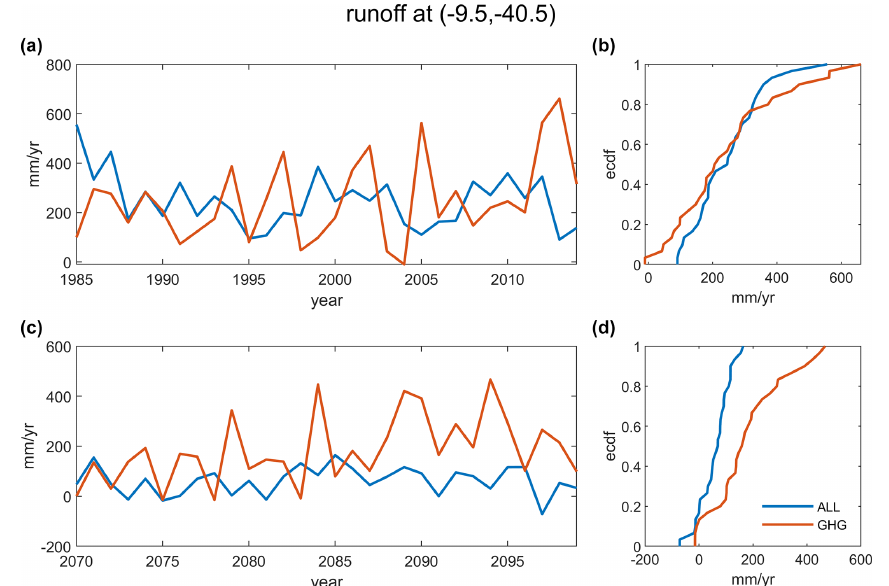
Figure A3. The 30-year mean annual runoff time series and eCDF from all forcing and GHG-only forcing simulations for historical period ( a , b ), and SSP5-8.5 period ( c , d ) at (9.5 ◦ S, 40.5 ◦ W), where the K-S test failed to reject ( F ) in the historical period and rejected ( R ) in the SSP5-8.5 period.